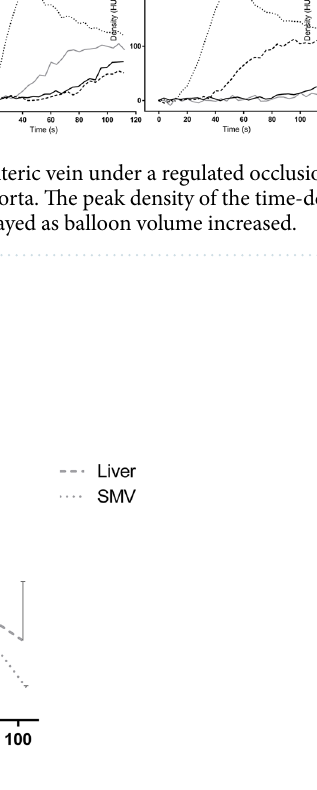
Figure 4. The change rate of the area under the time-density curve (AUTDC) during regulated occlusion volume in partial resuscitative endovascular balloon occlusion of the aorta. The AUTDC of the liver and the superior mesenteric vein (SMV) decreased linearly from 0 to 100% (liver, Y = −0.91*X + 108, R 2 = 0.90, P = 0.0043; SMV, Y = −1.0*X + 112, R 2 = 0.94, P =